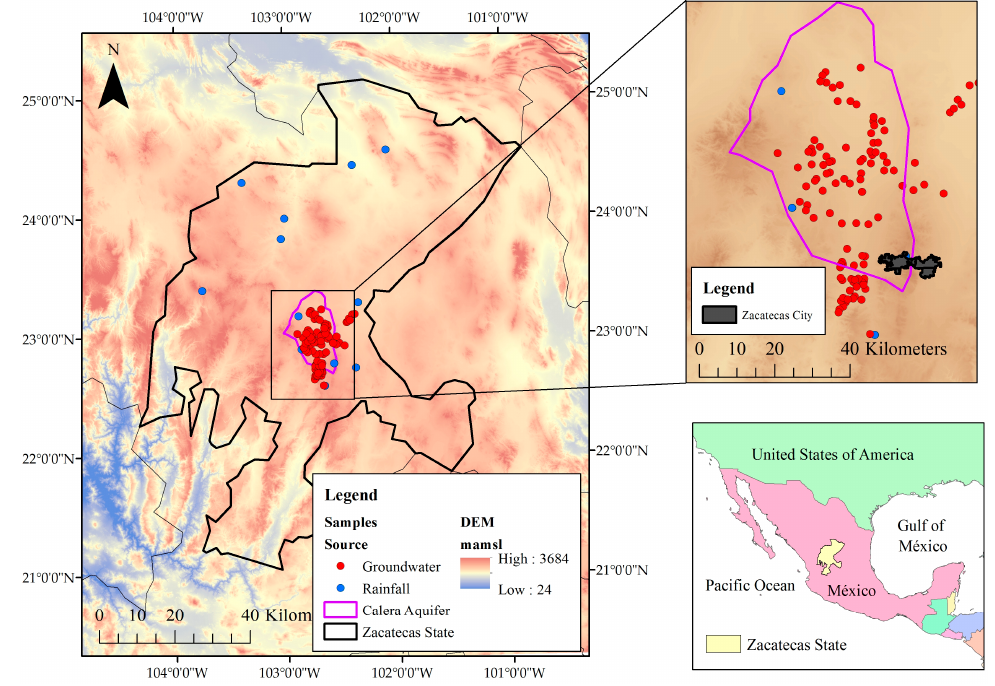
Figure 1. The location of the study area. Groundwater (red dots) and precipitation (blue dots) samples are shown. A digital elevation model as the background is also shown.